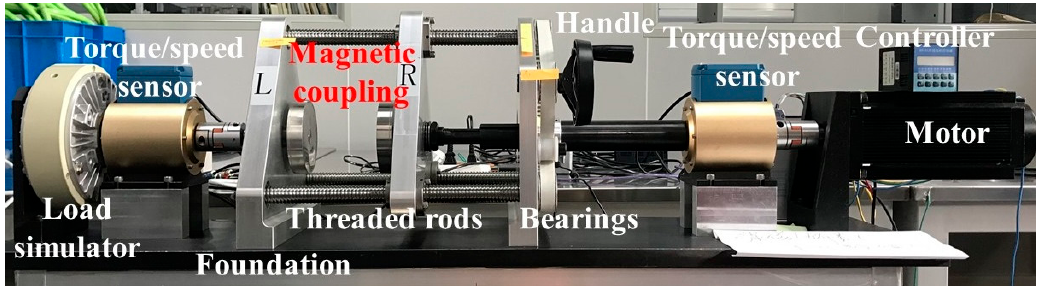
Figure 15. The test configuration of the experimental platform.